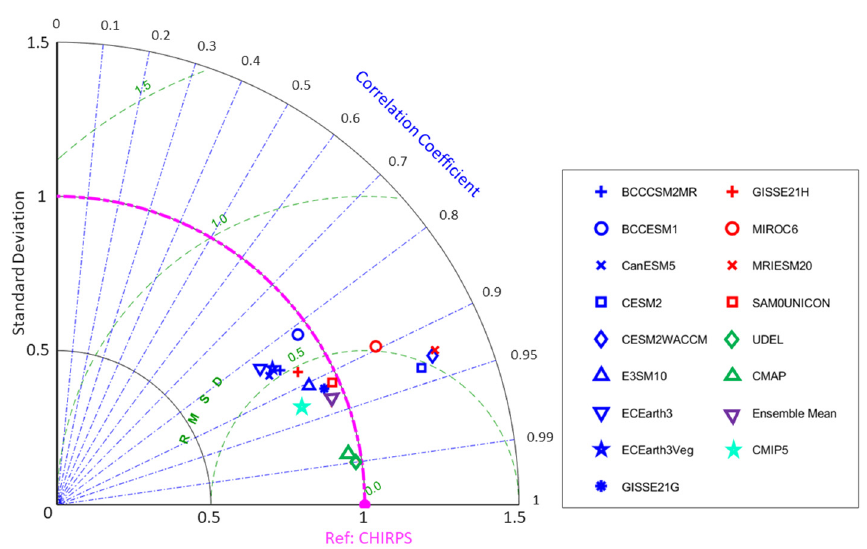
The model with the highest correlation coefficient is the ensemble mean with a value of 0.93 and the model with the lowest value is BCCESM1 at 0.82. The ensemble mean per- formed best for the entire Brazilian Amazon. Figure 3. The 1981–2014 precipitation standard deviation for observation and GCMs (mm day − 1 ).